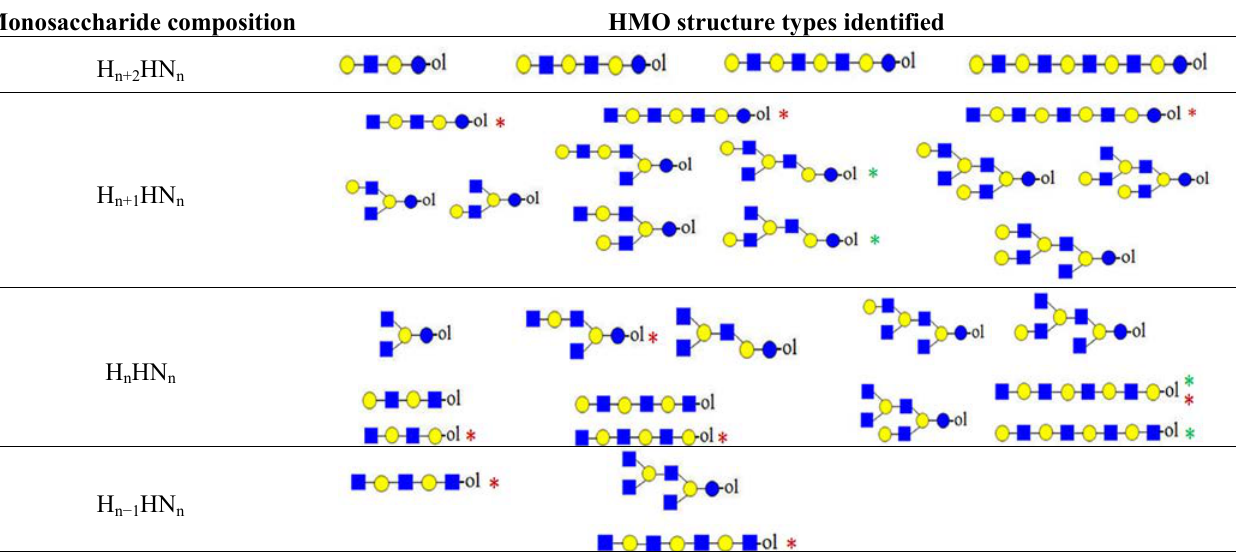
Table 3. Categorization of HMO structures identified in this study based on their monosaccharide composition. denotes N -acetylglucosamine, galactose and